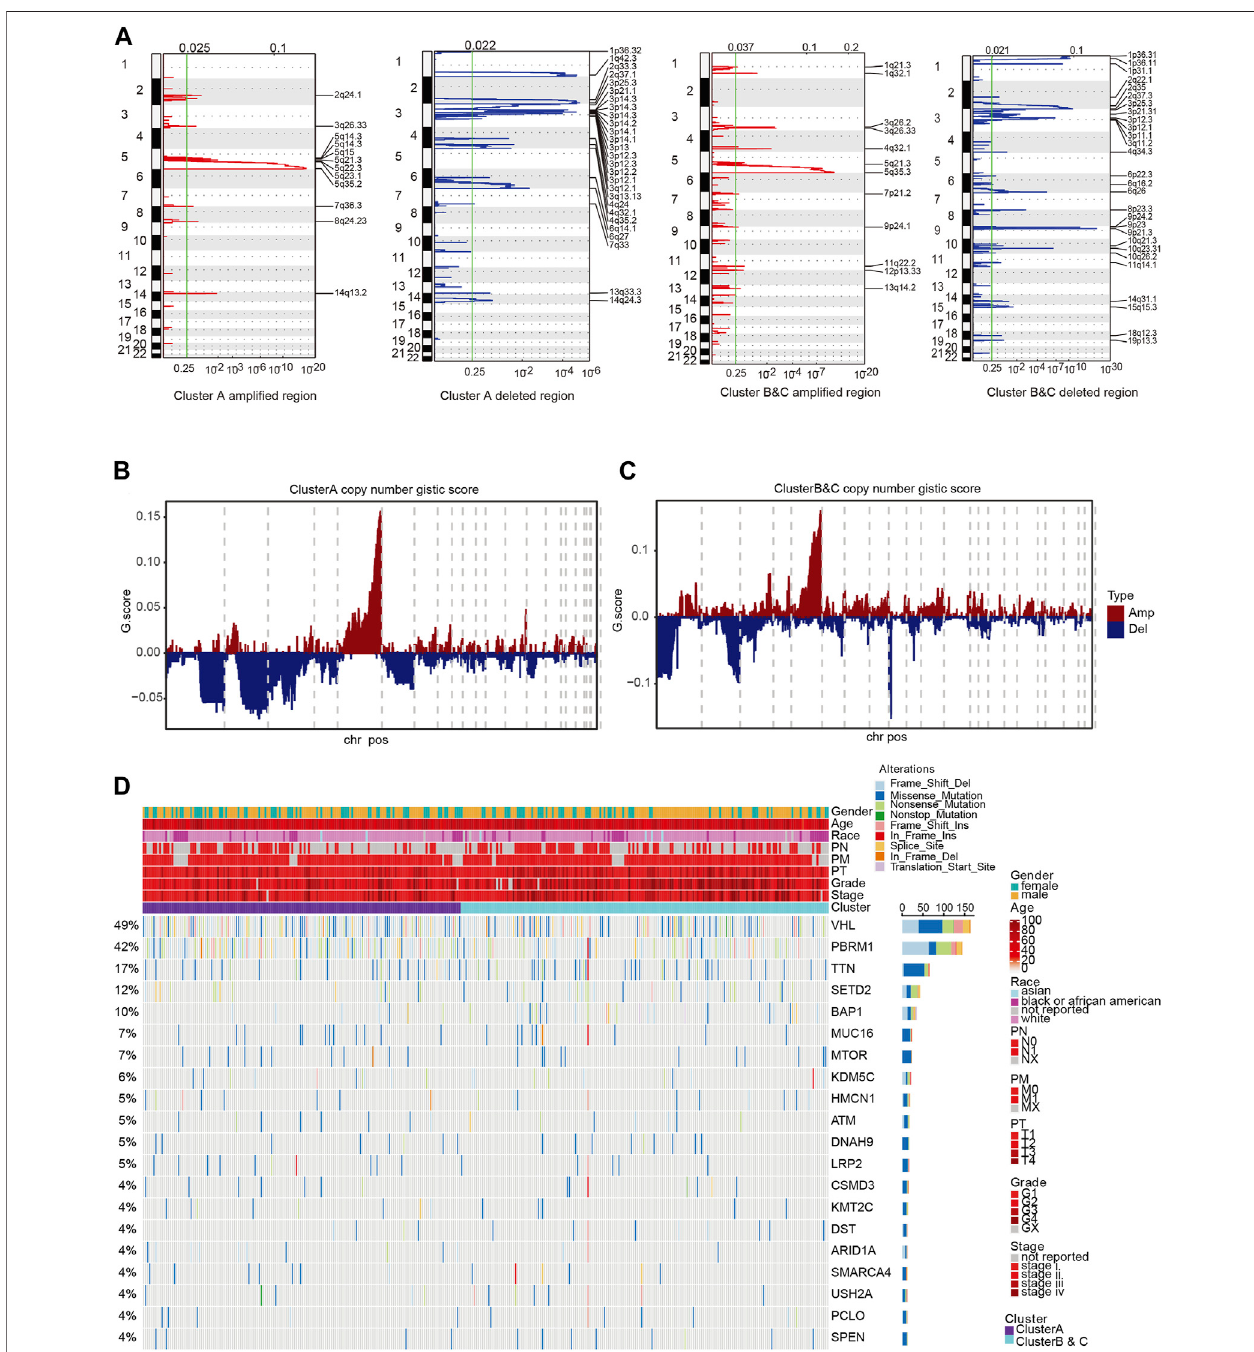
FIGURE 6 | Clinicopathological characteristics of immunophenotyping clusters. (A) Differences of various clinical indicators in different immunophenotyping clusters. (B, C) Methylation and mRNA expression level of CDKN2A in immunophenotyping clusters. (D) Total number of mutations in immunophenotyping clusters. (E – I) Phenotypic indicators, such as gender, age, tumor stage, smoking status, MSI, resection, and biopsy site, in the immunophenotyping clusters. (J) Patients in immunophenotyping clusters distributed according to AJCC stages.